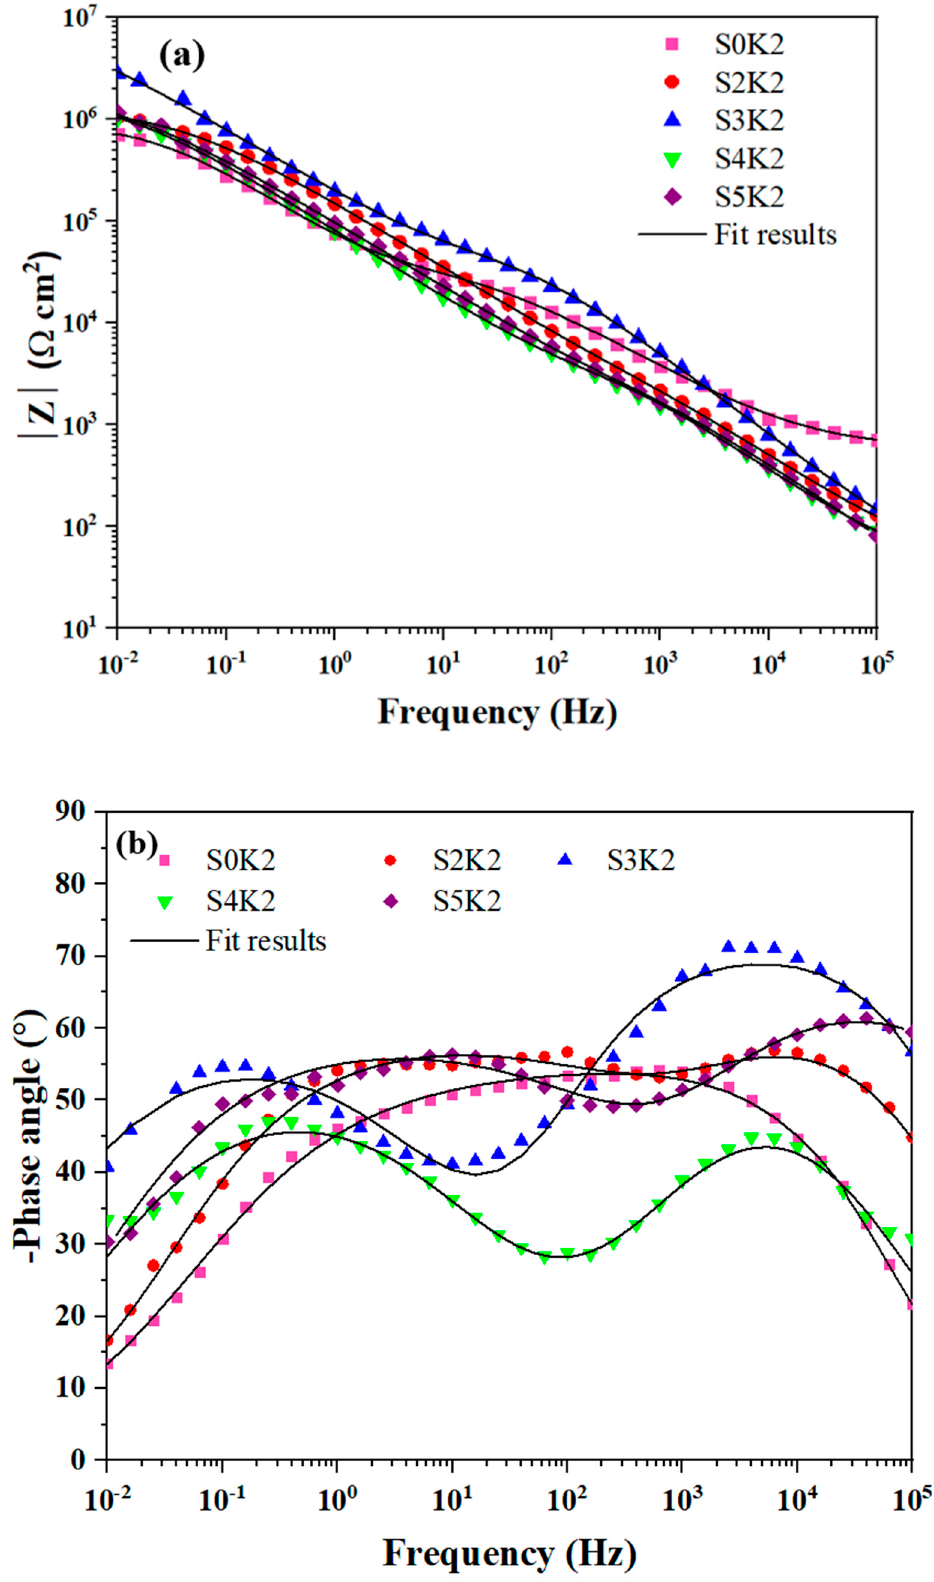
Figure 7. ( a ) Bode magnitude of impedance and ( b ) Bode phase plots of the PEO coatings prepared from coating solutions containing different concentrations of SMS recorded after 24 h immersion in 3.5 wt.% NaCl solution at pH 4.